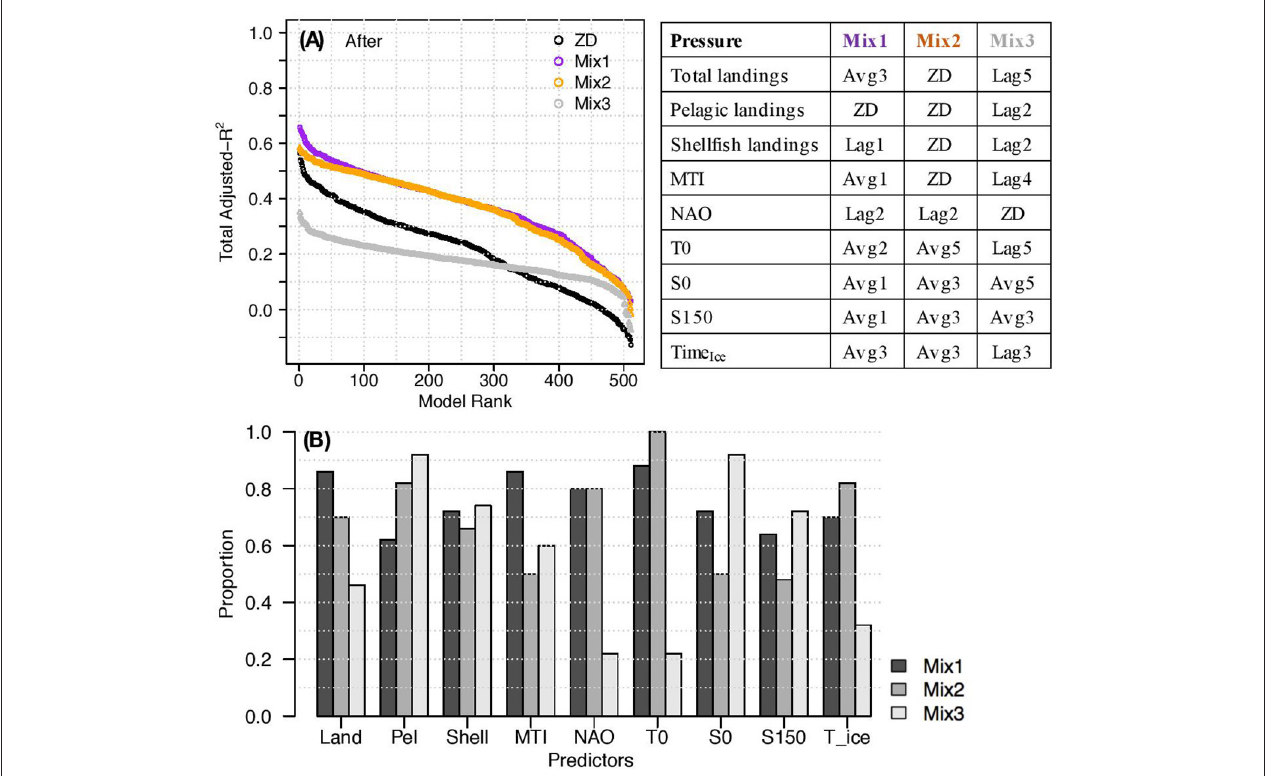
FIGURE 10 | (A) Adjusted-R 2 Total in decreasing rank for After models using predictors with mixed time delays; (B) Proportion of times each predictor appeared in the top 50 models for each set of After mix delays. Refer to table legend for type and length of delay used for each predictor.